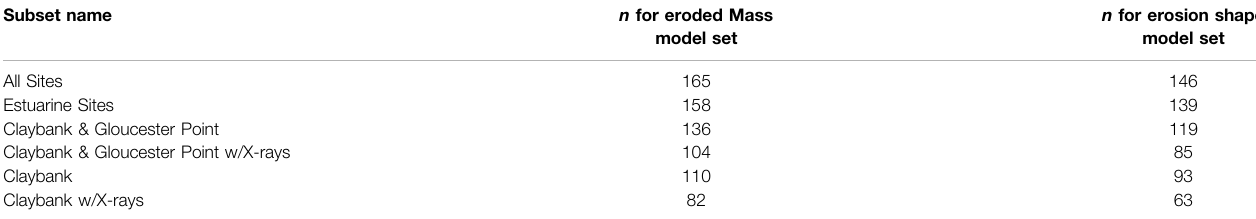
TABLE 1 | List of data subset names and sample sizes for the Eroded Mass Model Set and the Erosion Shape Model Set.